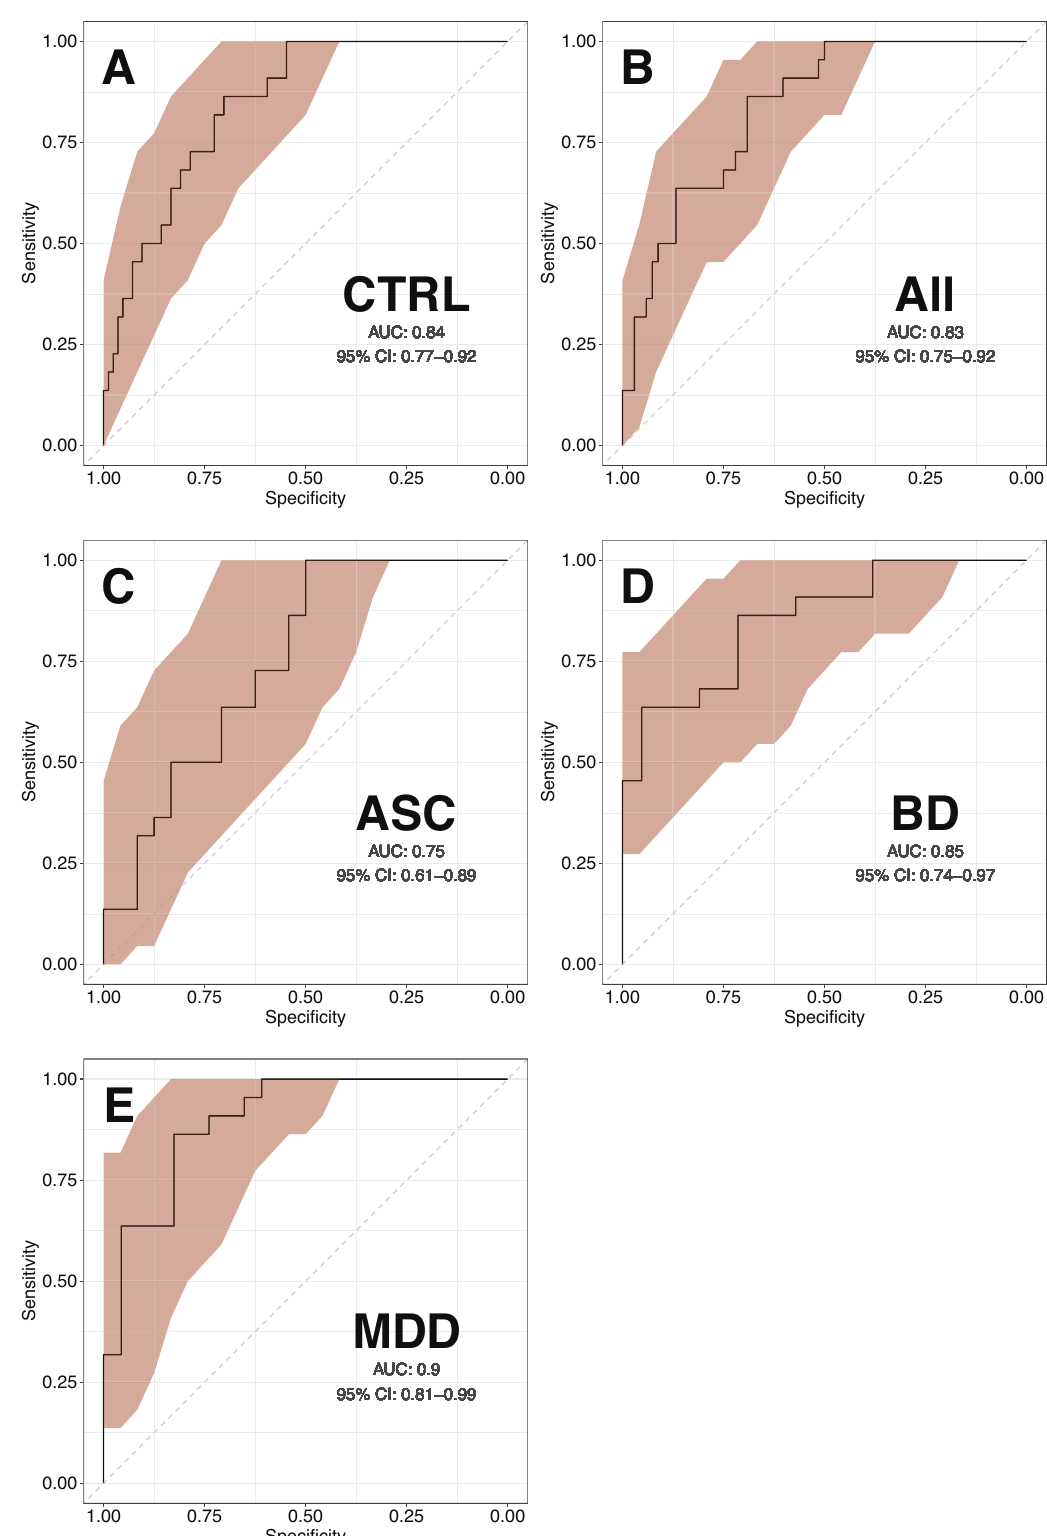
Fig. 4 Model performance in the psychiatric spectrum validation dataset. Plots show receiver operating characteristic curves (ROC) from applying the fi nal, two-biomarker model to differentiate fi rst-onset drug-naïve schizophrenia patients ( n = 22) from healthy control individuals (CTRL, n = 84; A ) as well as from patients with three other major neuropsychiatric conditions combined (All, n = 68; B ), including autism spectrum condition (ASC, n = 24; C ), bipolar disorder (BD, n = 21; D ) and major depressive disorder (MDD, n = 23; E ). Sensitivity con fi dence (CI) intervals are marked in red. AUC area under the ROC